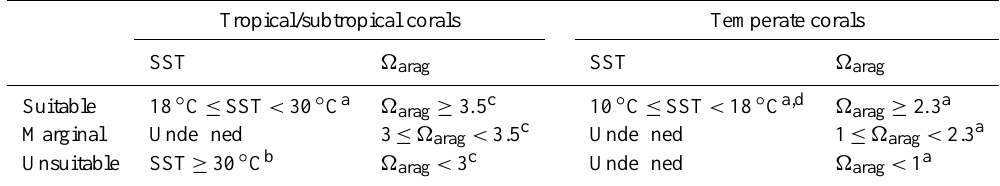
Table 1. Habitat characterization for the tropical/subtropical and the temperate coral communities. Tropical/subtropical